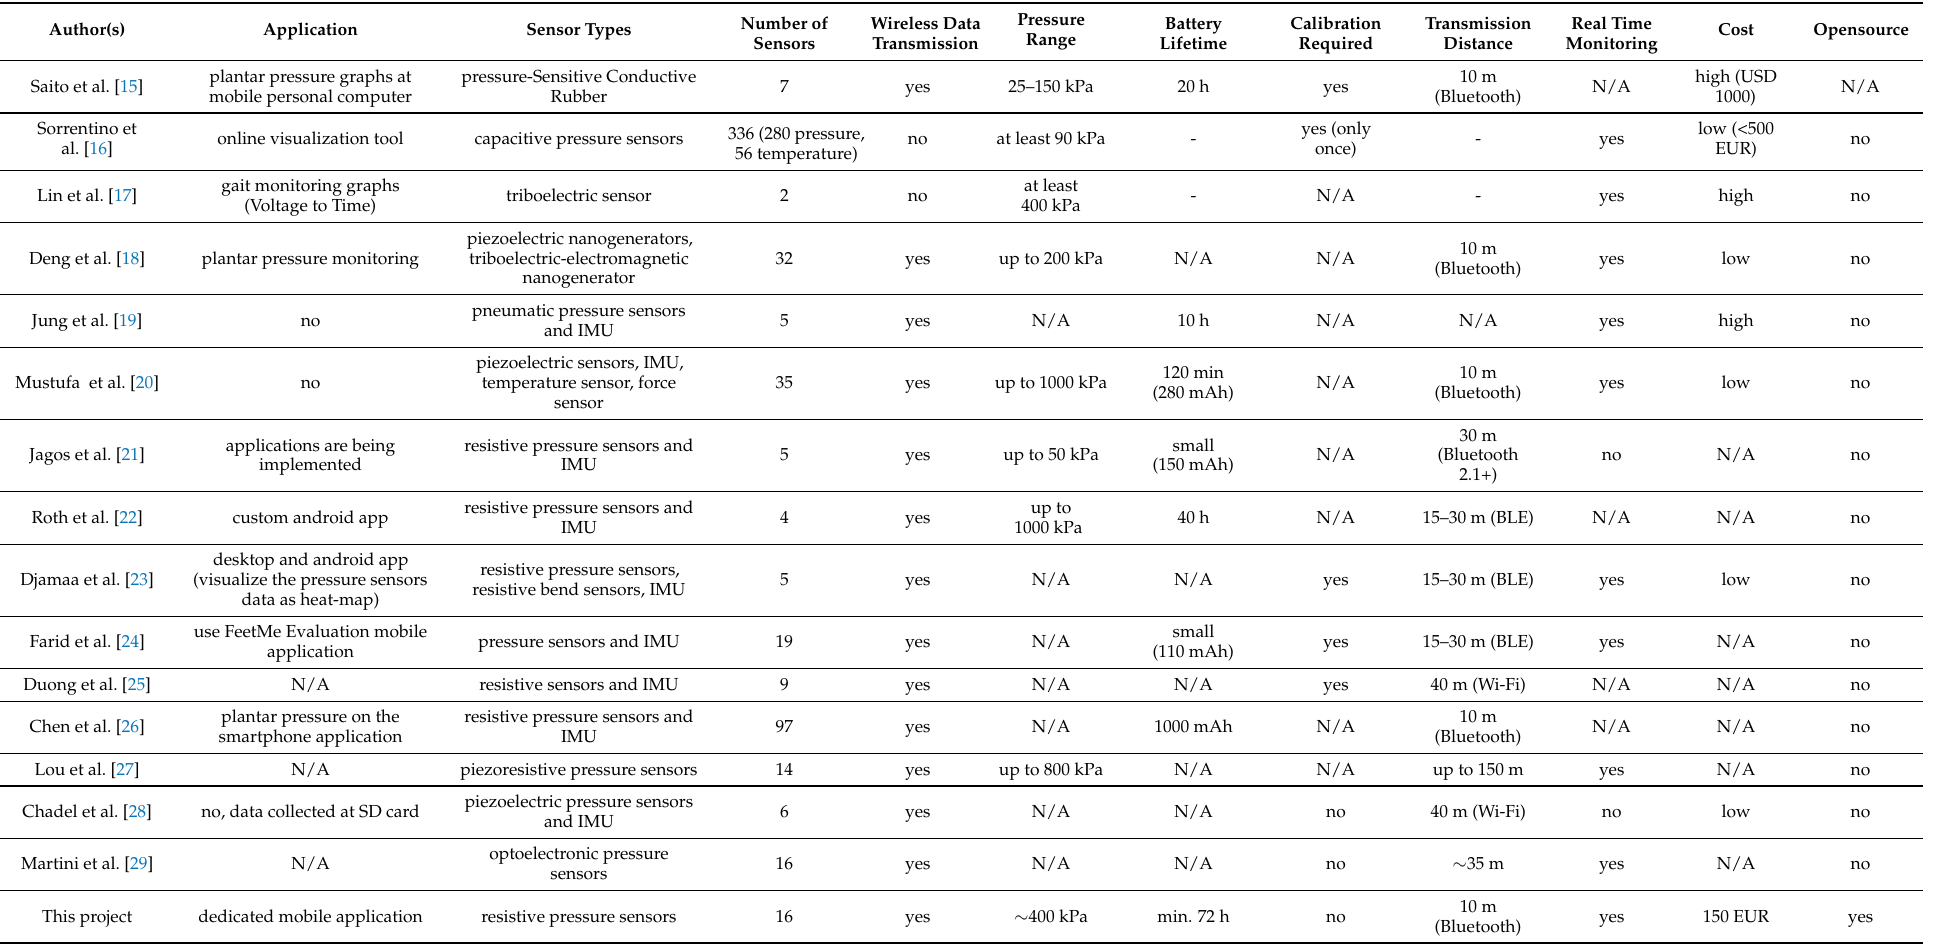
Table 1. General comparison of the developed solution with existing insole-based sensor systems used for gait and activity